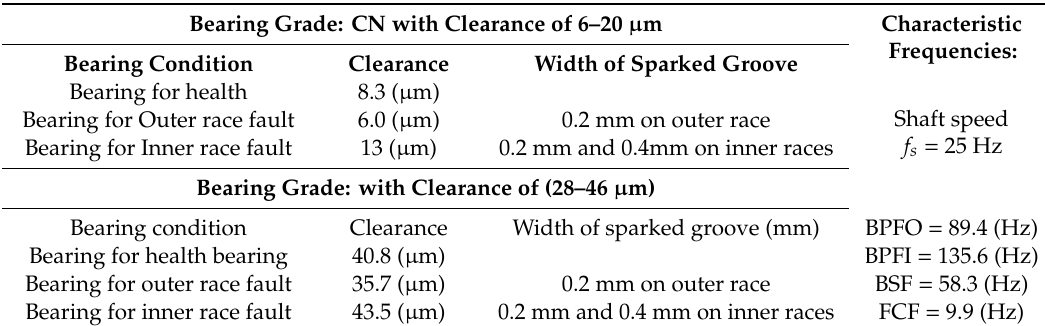
Table 1. 6206 deep groove ball bearing clearance values and local defect sizes.